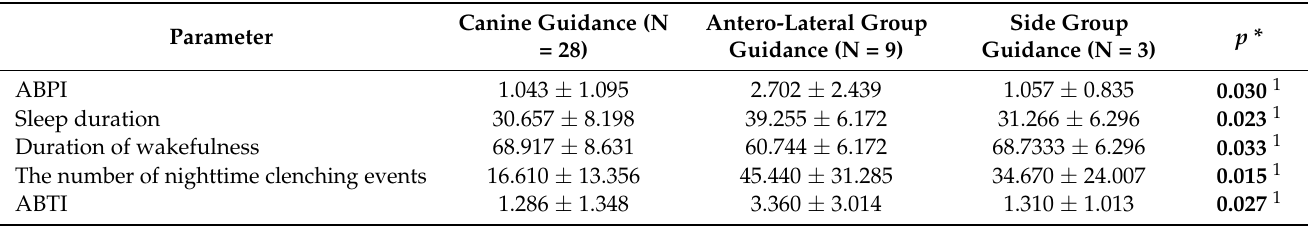
Table 11. The situation of the correlations between the type of guidance in the left laterotrusion movement and the indices of bruxism.